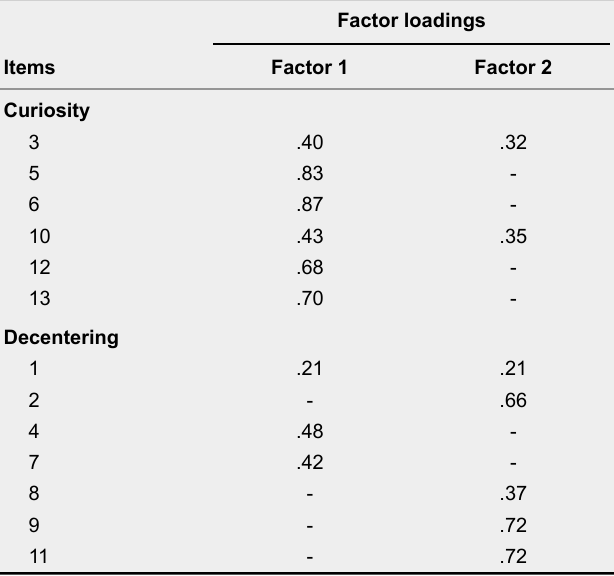
Factor loadings obtained from Exploratory Factor Analysis (EFA) Results Factor